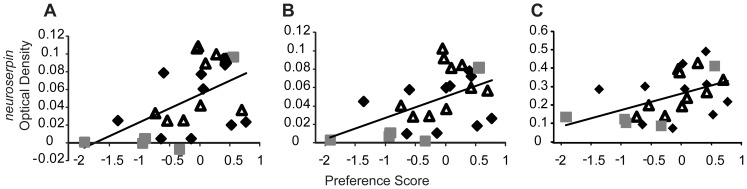
Individual variation of preference score and neuroserpin expression.Significant correlations between individual variation in preference score and neuroserpin expression in (a) Dm, (b) Dl, and (c) POA. Triangles, diamonds, and squares represent LL, LS, and SS exposed females, respectively.